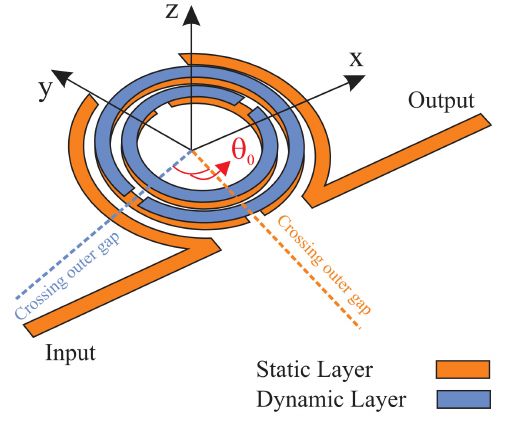
Figure 1. General schematic of the proposed sensor with a depiction of skew angle θ 0